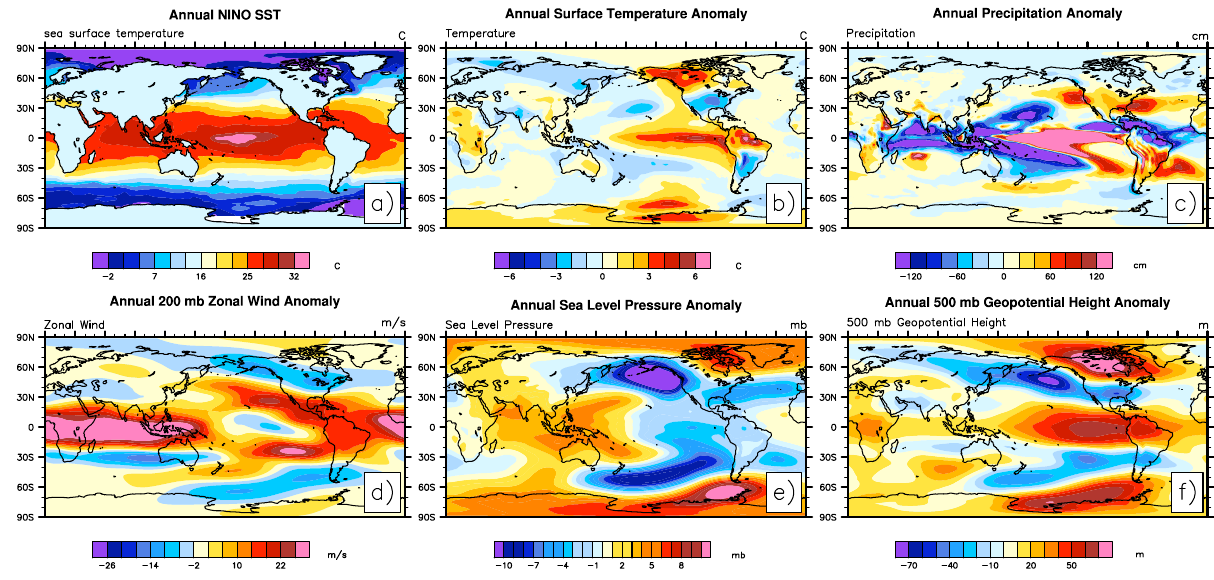
Fig. 2. (a) Specified mean annual SST distribution for the NINO case. The remaining fields are the mean annual anomalies between the NINO and MODERN case for basic atmospheric variables. (b) Surface temperature anomalies in ◦ C. (c) Cumulative precipitation anomaly in cmyear − 1 . (d) Zonal wind anomaly (ms − 1 ) interpolated to the 200mb pressure level. (e) Sea level pressure anomaly in mb. (f) Geopotential height anomaly in